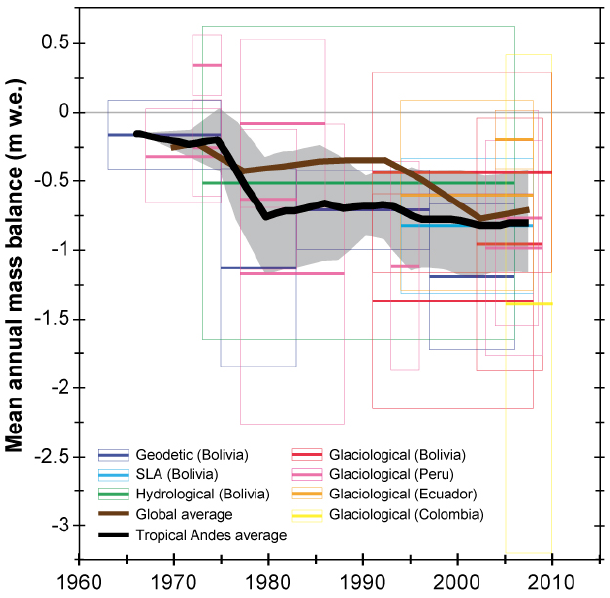
Fig. 7. Compilation of all available measured rates of change in mass balance in the tropical Andes. Glaciological and hydrological measurements are made annually; geodetic measurements are pluri- annual and result from sporadic photogrammetric surveys. “SLA” represents the reconstruction of mass balance using variations in snow line altitude. Each budget is drawn as a thick horizontal line contained in a ± 1standard deviation box. The tropical Andes aver- age was computed from available data and has been smoothed using a 5-yr running mean, the light grey box around the average rep- resents the ± 1standard deviation. The global average comes from Cogley (2012).